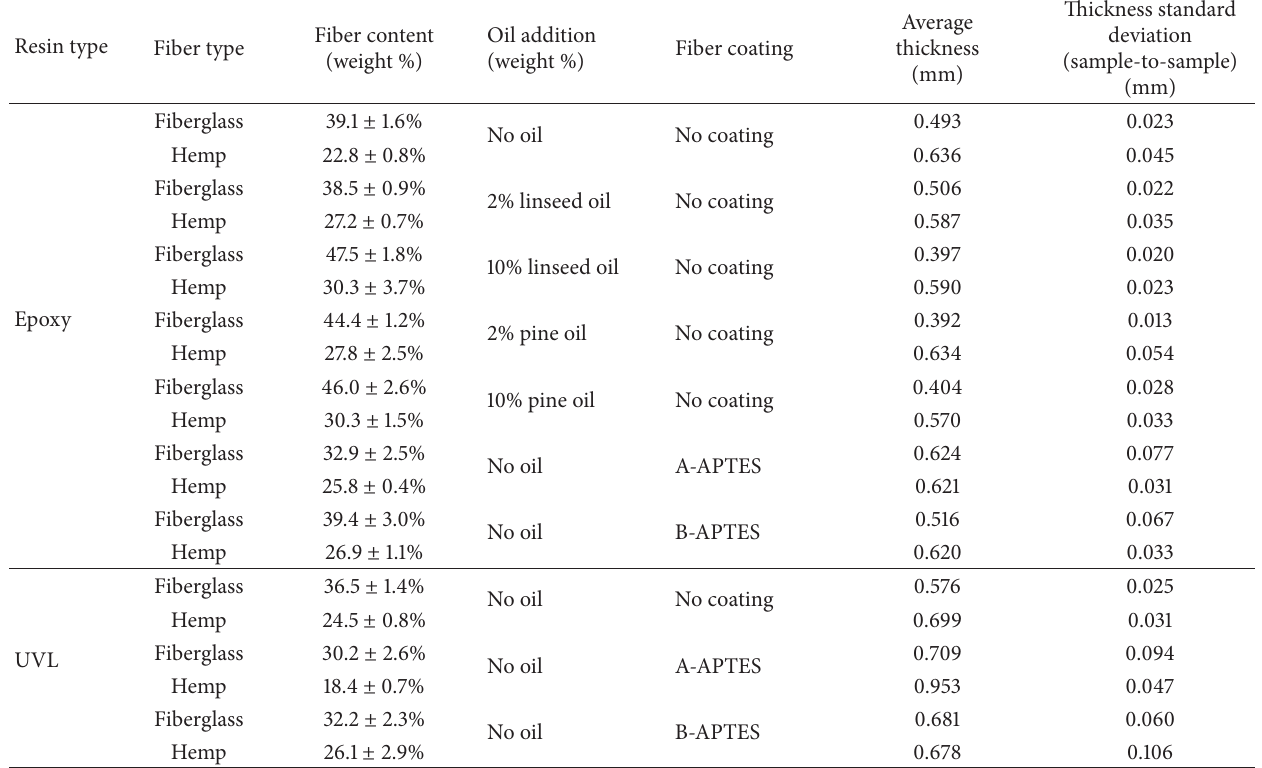
Table 1: Composite sample types and their